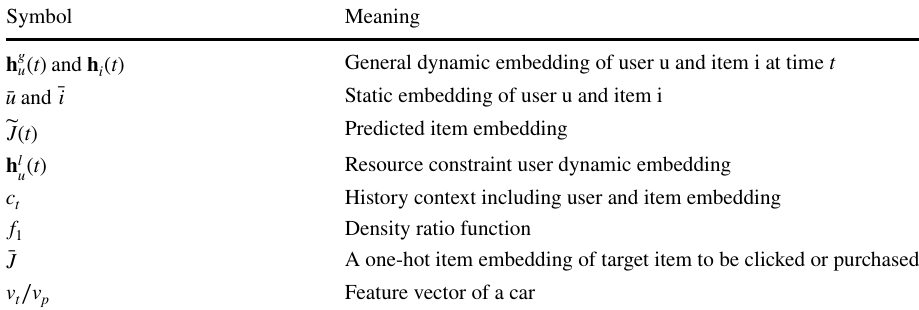
Table 1 Symbols used in this